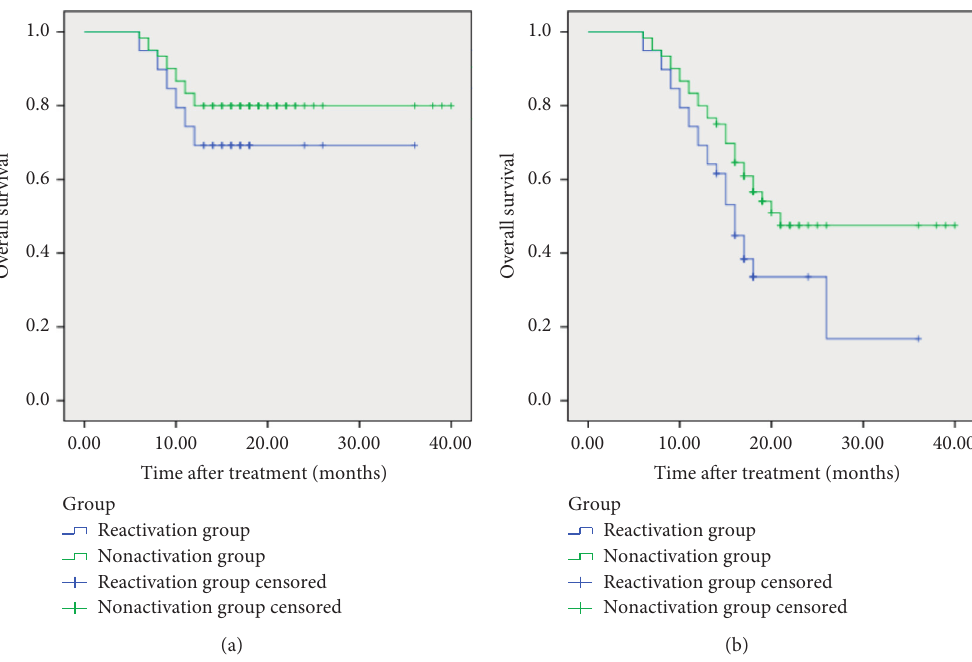
Figure 1: Survival curve of HBV-reactivated patients and HBV-nonreactivated patients. (a) Curve of one-year survival rate. (b) Curve of two-year survival